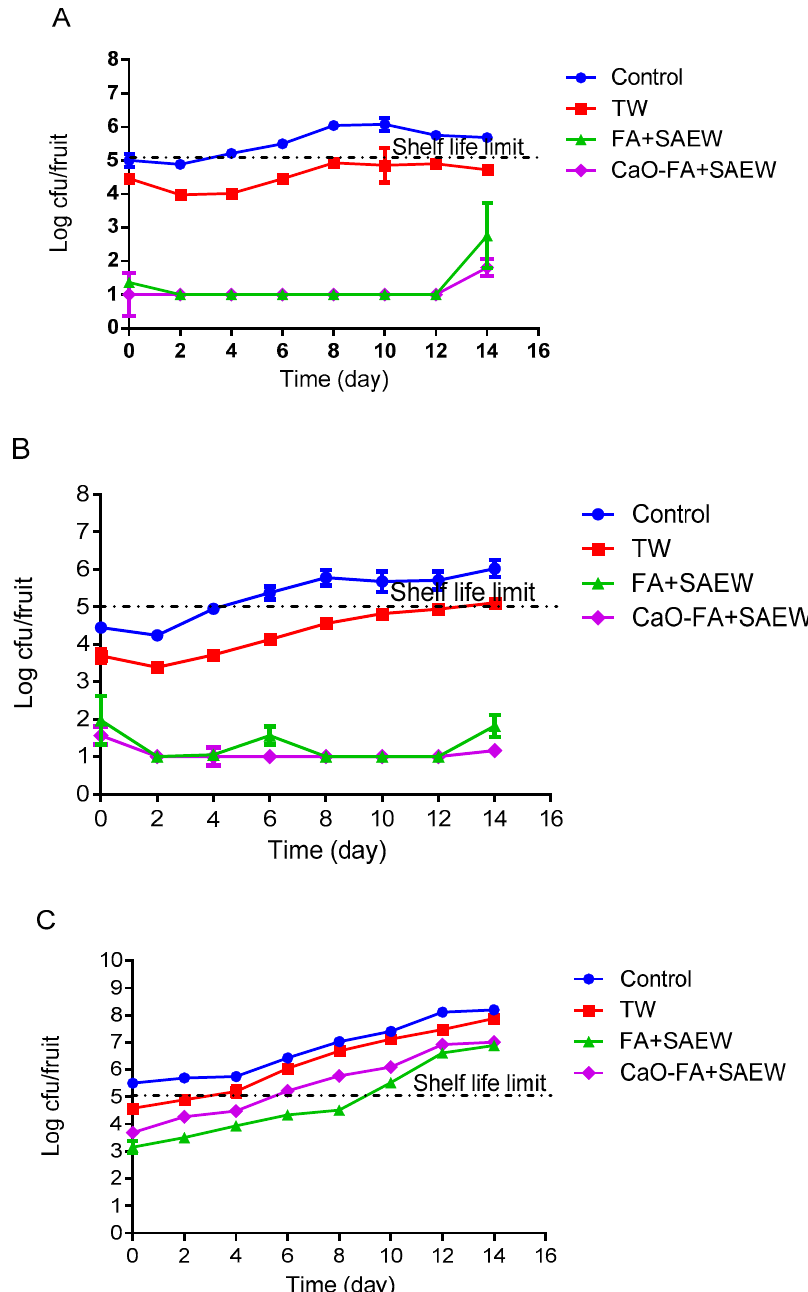
Figure 5. The growth of yeast and mold on fruits during storage at 4 °C after different treatments. TW: Tap water; FA + SAEW: Combination of FA and SAEW treatment; CaO-FA + SAEW: Calcium oxide washing followed by combination of FA + SAEW treatment. Red line represents the end of shelf-life. ( A ) Apple; ( B ) mandarin; ( C ) tomato. Vertical bars represent standard error of the mean ( n = 3).